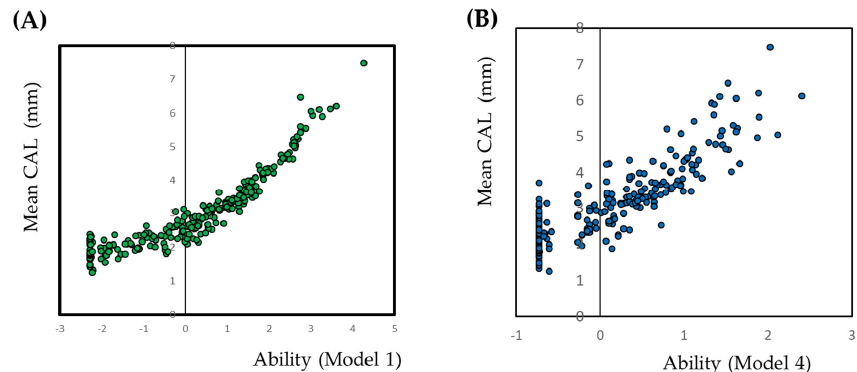
Figure 2. Scatter plot of the mean value of the clinical attachment level against the ability calculated